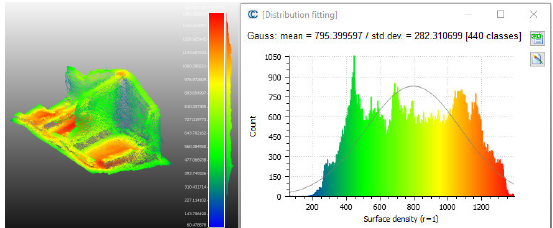
Figure 9b. Density analysis of the project 1 (the two nadiral acquisitions) – Sample B